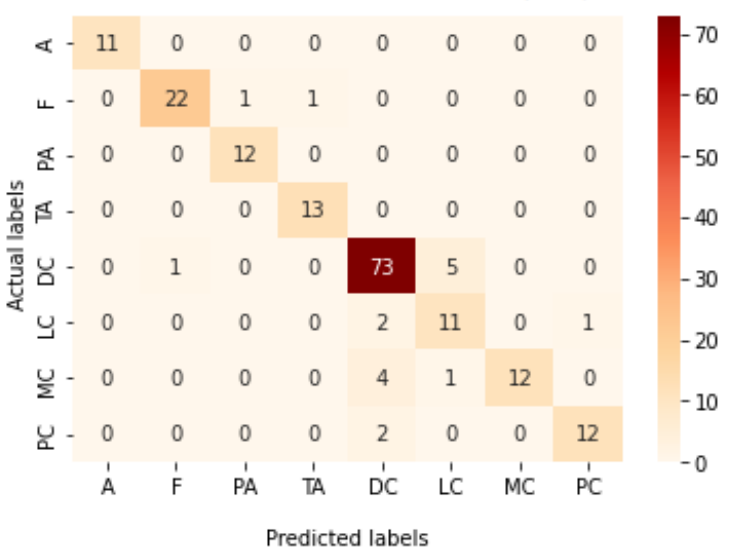
Figure 30. Confusion matrix of Xception model in 400× magnification-dependent multi-classifica- tion.